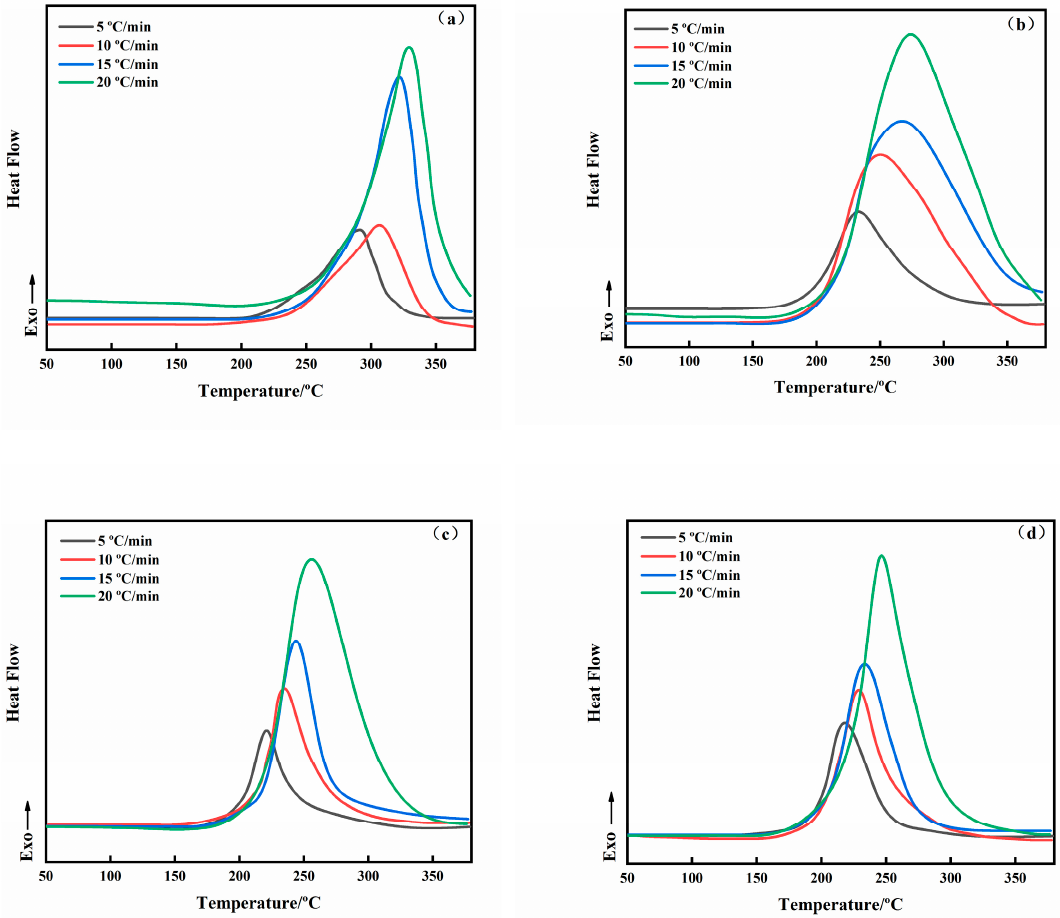
Figure 8. Dynamic DSC curves at different heating rates of neat ( a ), 4 ( b ), 8 ( c ), and 10 wt% ( d ).